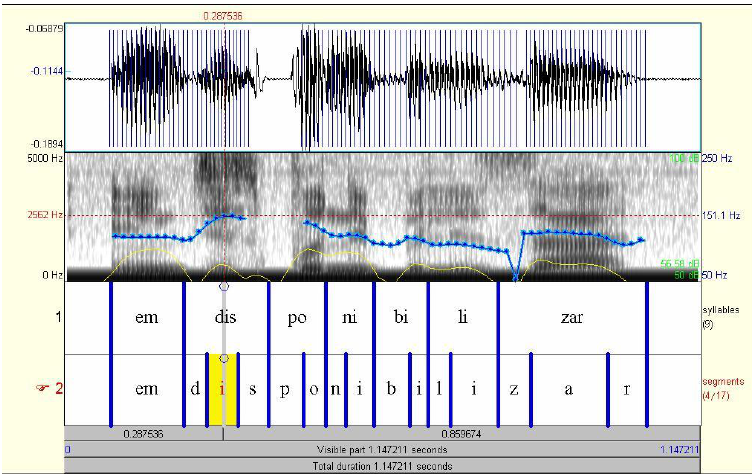
Figure 1. F 0 contour (top line) and intensity (bottom line) of the PWd em DISponibili ZAR (“make available”), produced by a BP speaker